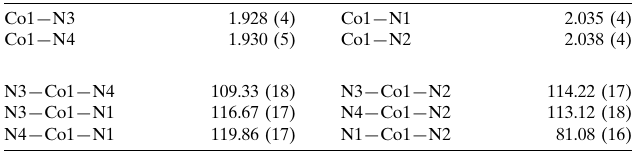
Selected geometric parameters (A˚ , (cid:1)